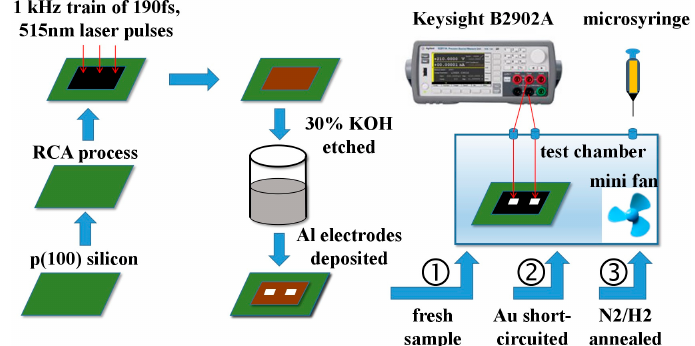
Figure 2. Schematic diagram of sensor fabrication and sensing test system.